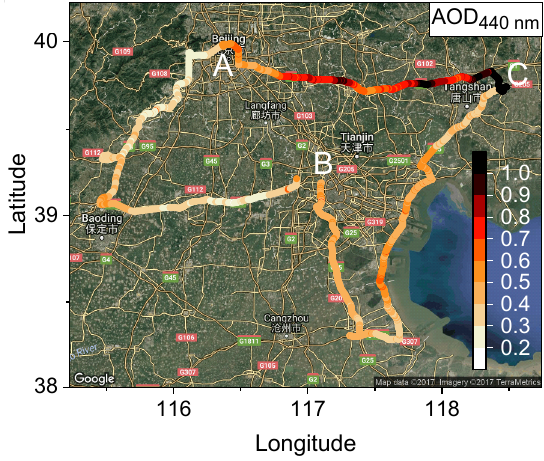
Figure 2. Spatial variability of AOD at 440 nm from PLASMA sun photometer measurements. The A, B and C denote the departure and arrival points for